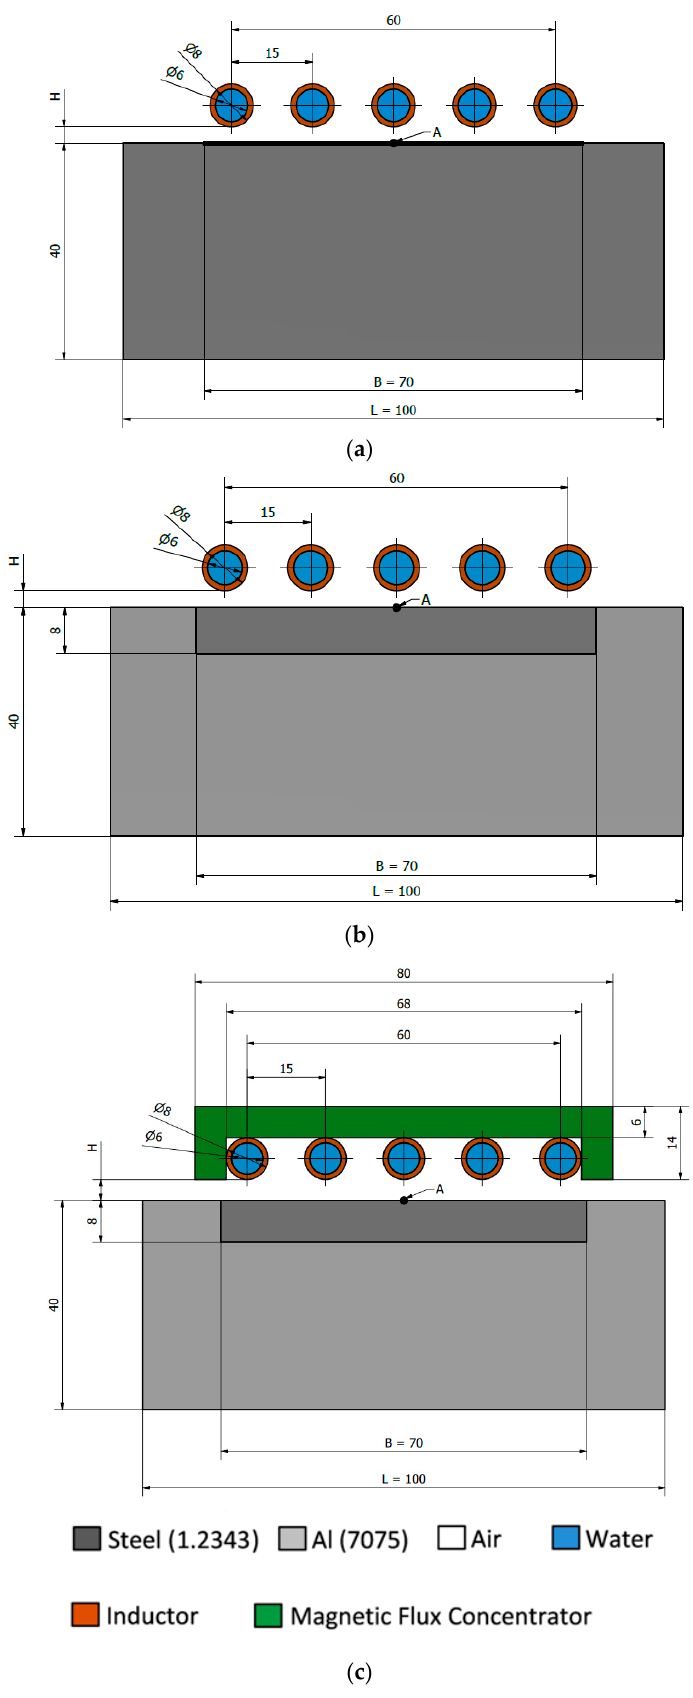
Figure 1. Geometries of ( a ) the steel block (P1); ( b ) the steel insert in the aluminum block (P2); ( c ) the steel insert in the aluminum block with the use of the magnetic flux concentrator